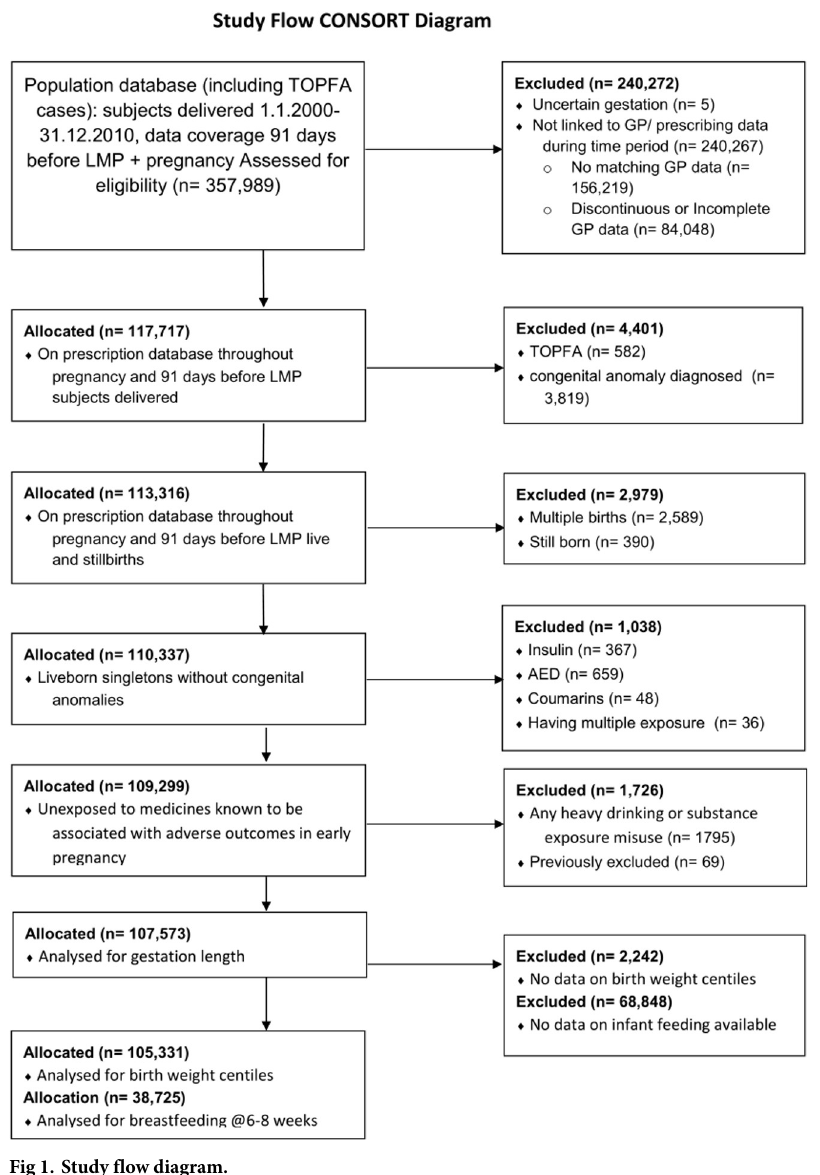
Fig 1. Study flow